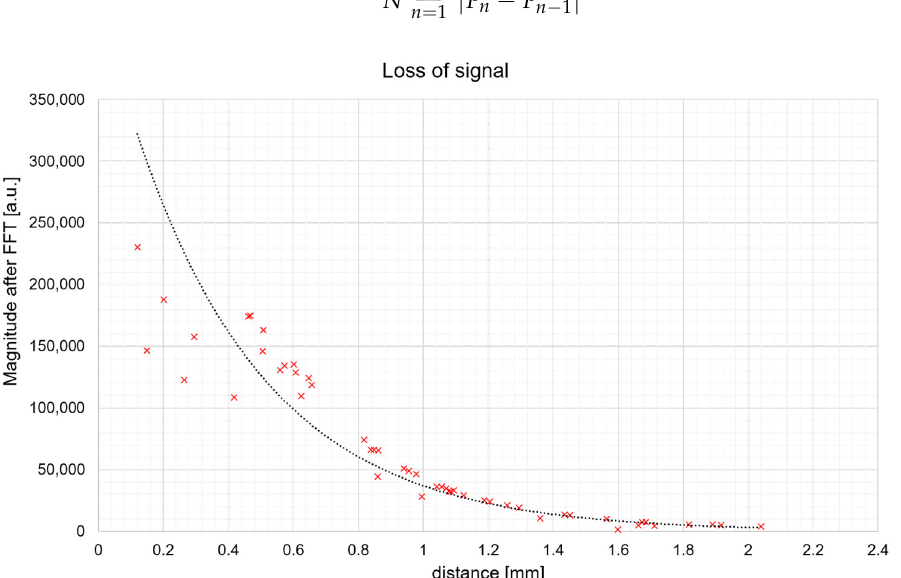
Figure 5. Loss of the measuring signal with increasing measuring distance. The magnitude of the signal decreases with increasing measuring distance until it can no longer be distinguished from the background noise. The red crosses represent one of the random meas.